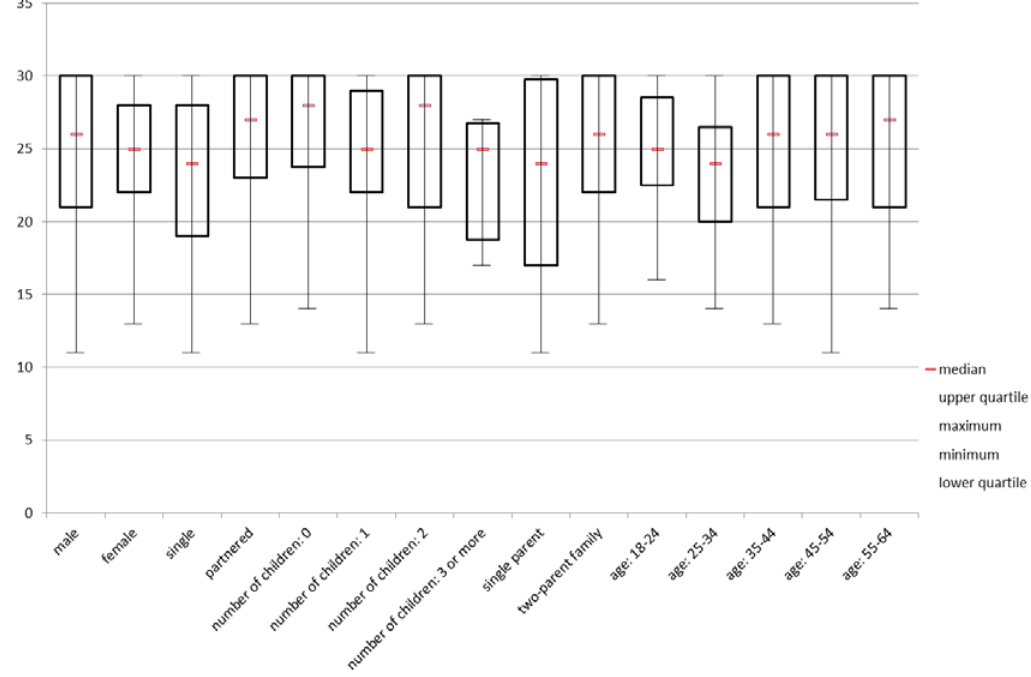
Figure 3. Basic distribution of the work-family balance scores across demographic characteristics, N = 383.